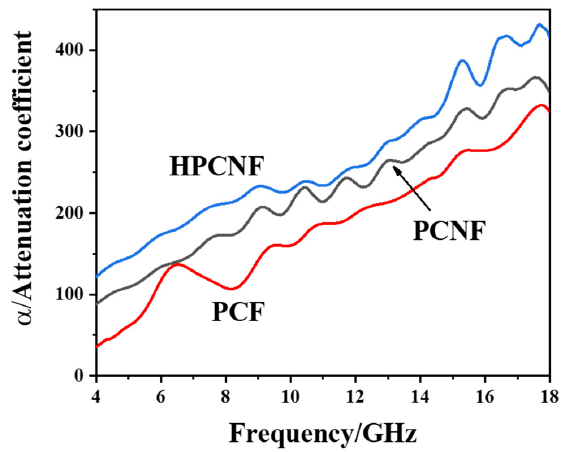
Figure 10. Attenuation coefficients of microwave absorbing composites prepared with different ab- sorbers.